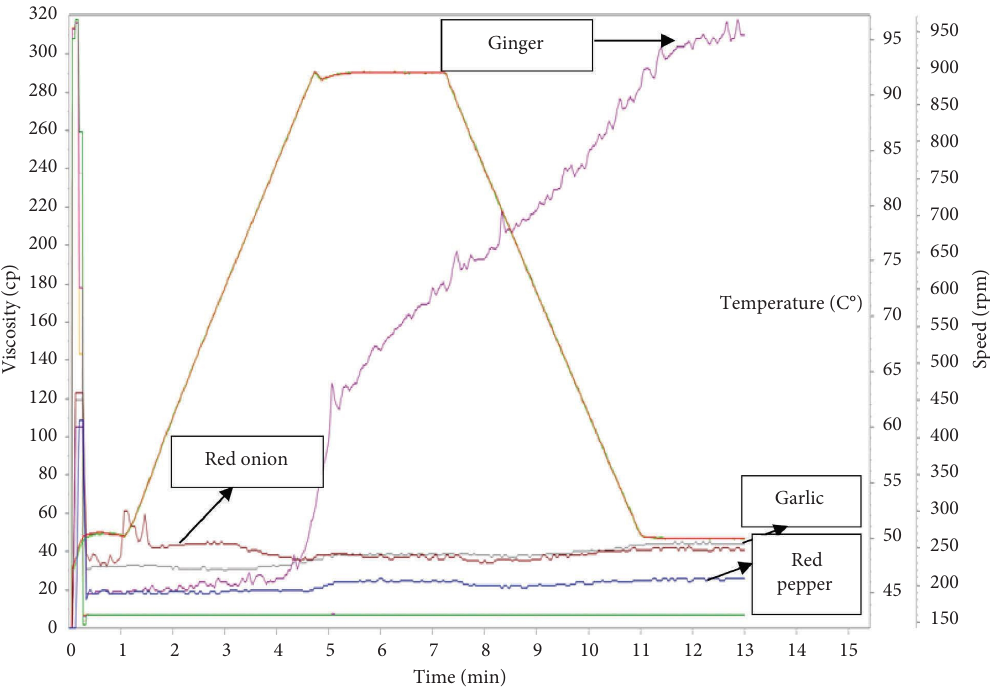
Figure 7: Pasting properties of red pepper, red onion, ginger, and